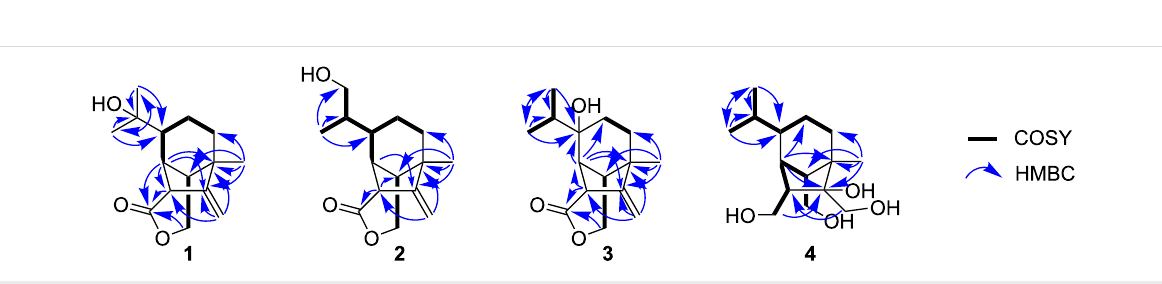
were α -oriented. The absolute configuration of 1 was deter- mined to be 1 R ,3 R ,6 S ,7 R ,13 S by comparison of the experimen- tal electronic circular dichroism (ECD) spectrum with time-de- pendent density functional theory (TDDFT)-calculated ECD spectra of the two possible enantiomers of 1 (Figure